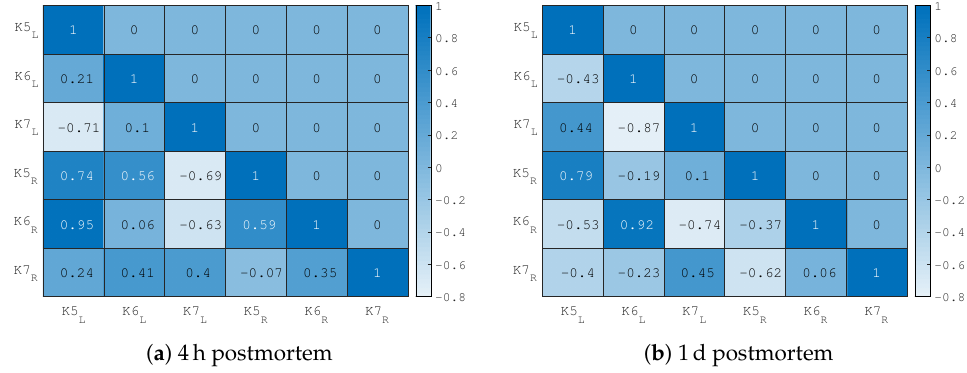
Figure 14. Correlation values between frequency characteristics of different VFs (normalized curves shown in Figure 13). The results for the measurement 4h are shown in the subfigure ( a ) and 1d postmortem in subfigure ( b ). The saturation of the cell indicates the value of the correlation coefficient.